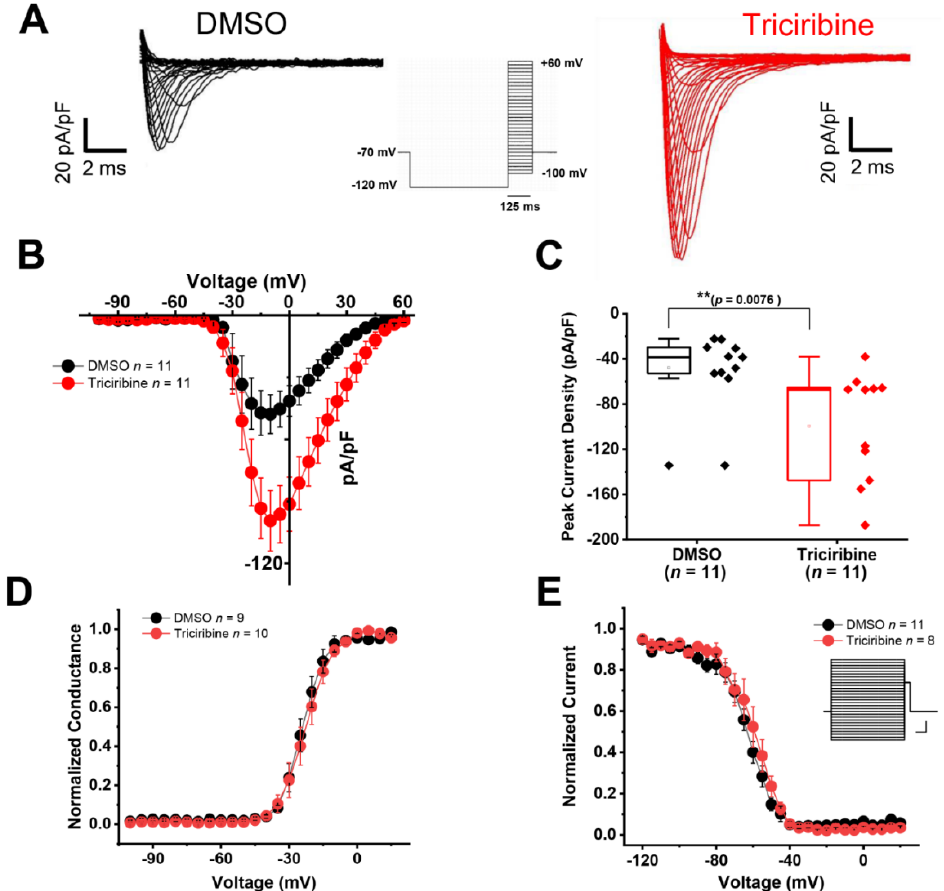
Figure 1. Pharmacological inhibition of Akt by triciribine leads to an increased I Na current density in HEK-293 cells expressing Na v 1.6. ( A ) Representative traces of I Na currents recorded from HEK-Na v 1.6 cells treated for 60 min either with DMSO (0.1%) (black) or 30 µM triciribine (red). ( B ) Current–voltage relationship showing increased peak I Na current densities in triciribine-treated HEK-Na v 1.6 cells (red, n = 11) compared to DMSO control (black, n = 11). ( C ) Peak current density at voltage step of − 10 mV in DMSO and triciribine-treated HEK-Na v 1.6 cells. A 60 min treatment with triciribine (30 µM) significantly increased the Na v 1.6-mediated peak I Na current density ( n = 11 in both group; ** p = 0.0076 with Student’s unpaired t -test). ( D , E ). Voltage dependence of I Na activation ( D ) and steady-state inactivation ( E ) in DMSO and triciribine-treated HEK-Na v 1.6 cells. Treatment with triciribine did not affect voltage dependence of I Na activation or steady-state inactivation. Inset shows the inactivation protocol (scale bars: 20 mv/100 ms). Box plot shows: Range (Perc 25, 75), Mean, Median, Min, and Max. Results are summarized in Table 1.